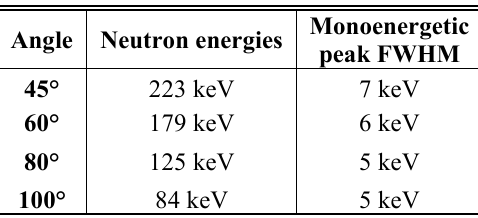
Table 1 Angles relative to proton beam direction and corresponding neutron energies